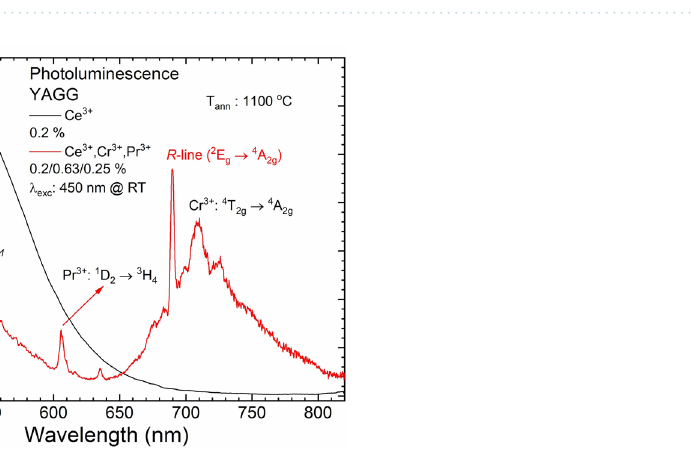
Figure 3. PL spectra of ( a ) YAGG:Ce 3+ and ( b ) YAGG:Ce 3+ ,Cr 3+ ,Pr 3+ nanophosphors annealed at different temperatures. λ exc : 450 nm at RT.